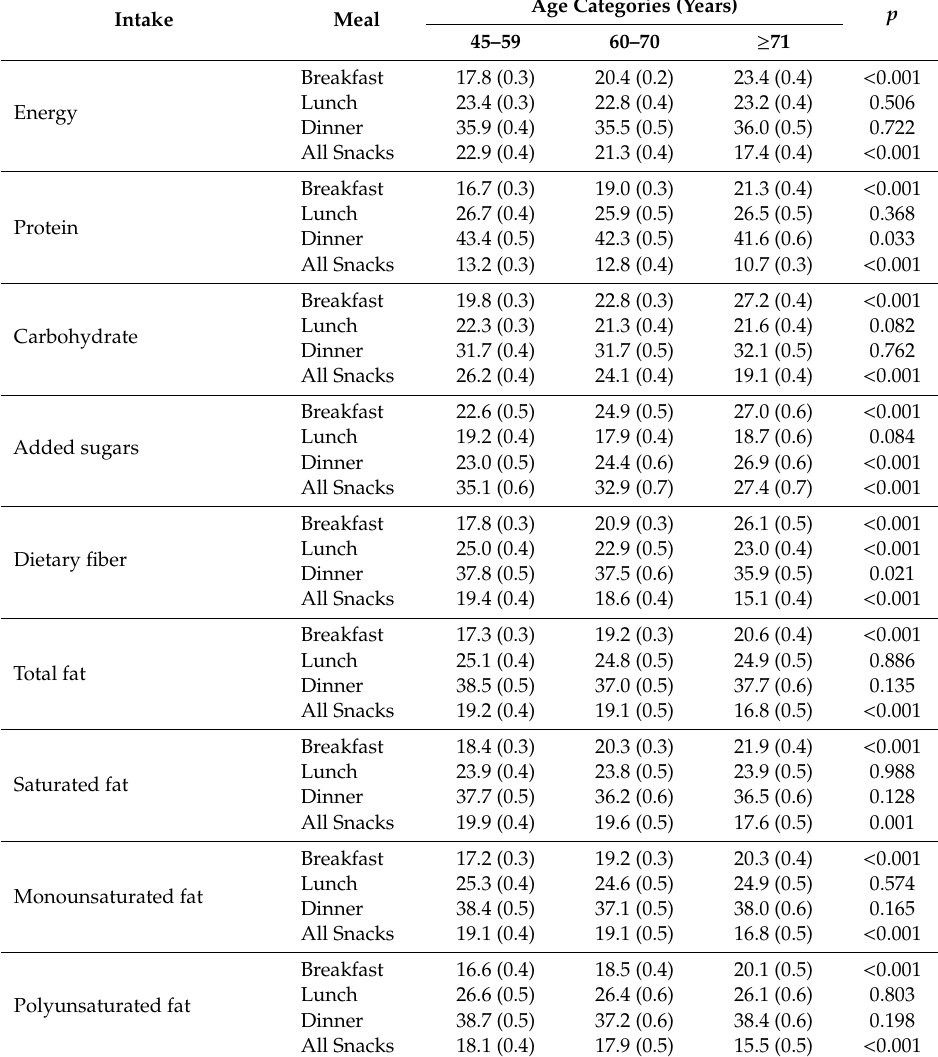
Table 3. Mean percent intakes from each meal and all snacks by age group.